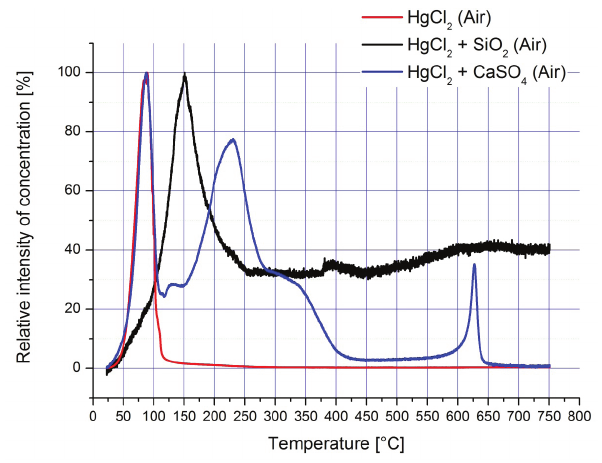
, purged with nitrogen. 2